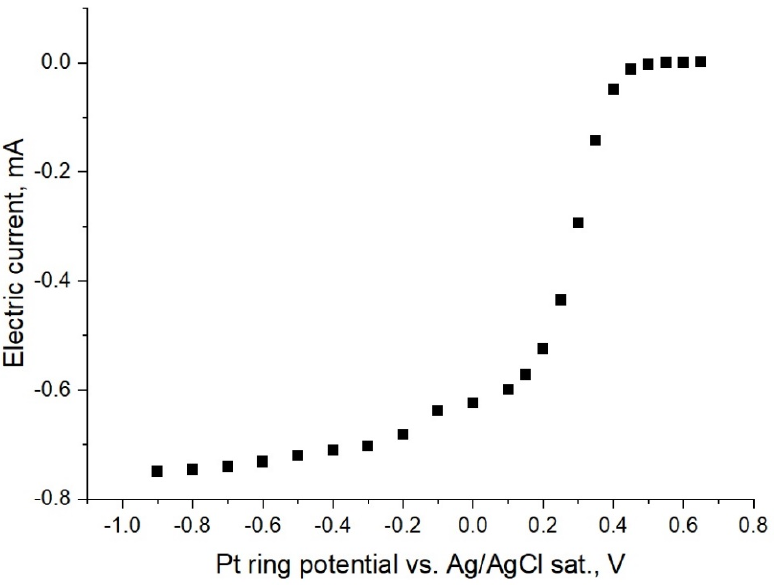
Figure 6. The Pt ring collected current vs. the potential dependence under stationary conditions for